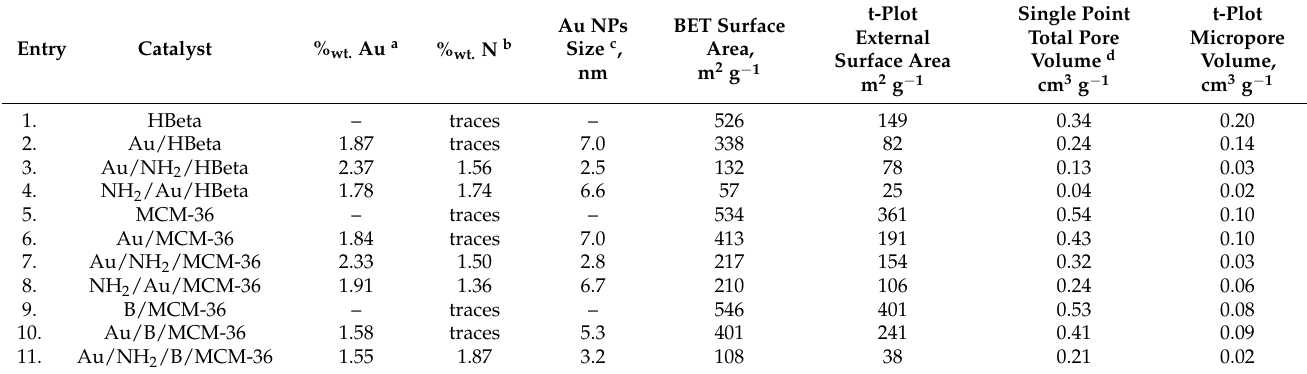
Table 1. Composition, mean Au NPs sizes and textural properties of prepared